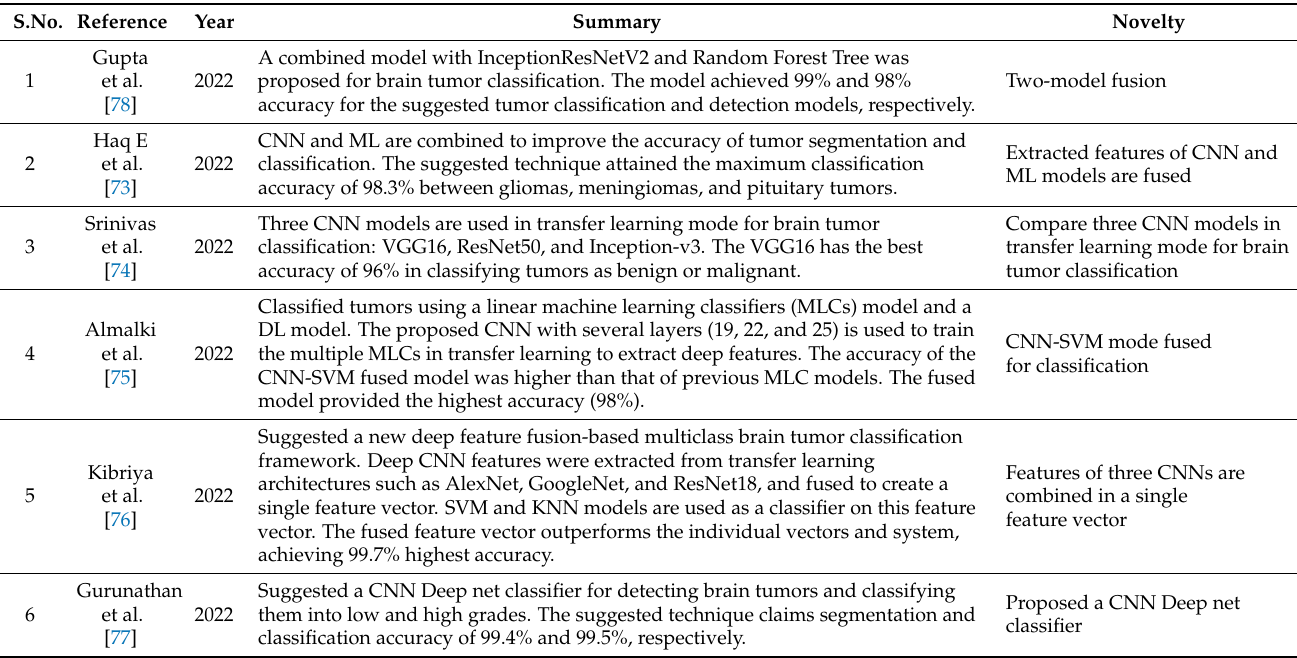
Table A1. Comparison of the earlier proposed works.